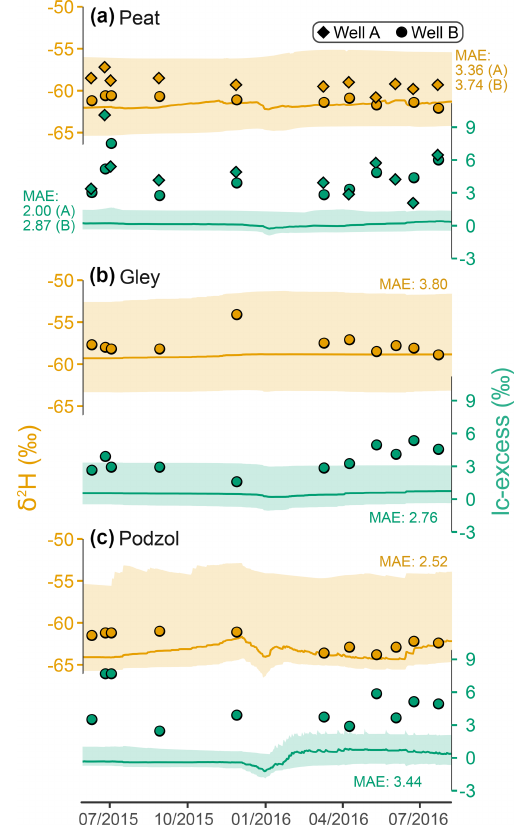
Figure 6. Time series of deuterium composition (orange) and lc- excess (green) in groundwater at different locations in the catch- ment. Measurements are shown with symbols – with two wells on the same simulated peat grid cell, on opposite sides of the stream – while solid lines and ribbons show the median and 90% confidence interval of ensemble simulations, and the median model–data MAE values are